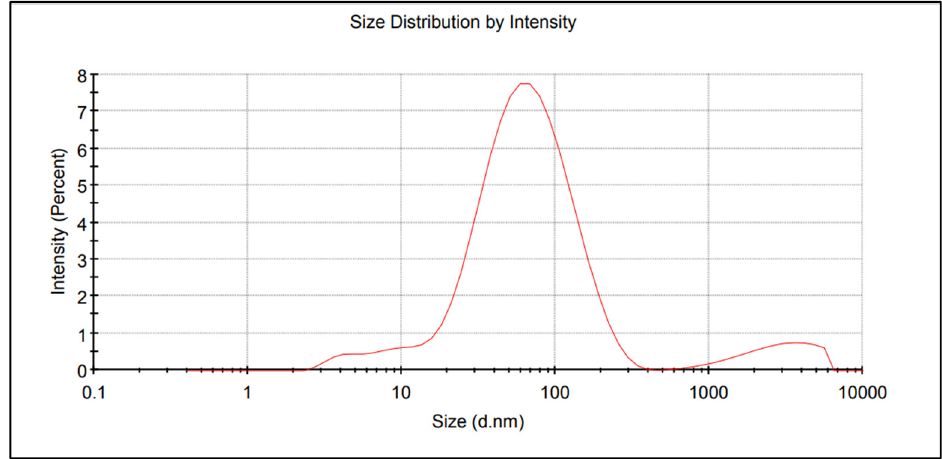
Figure 1. Size distribution report of